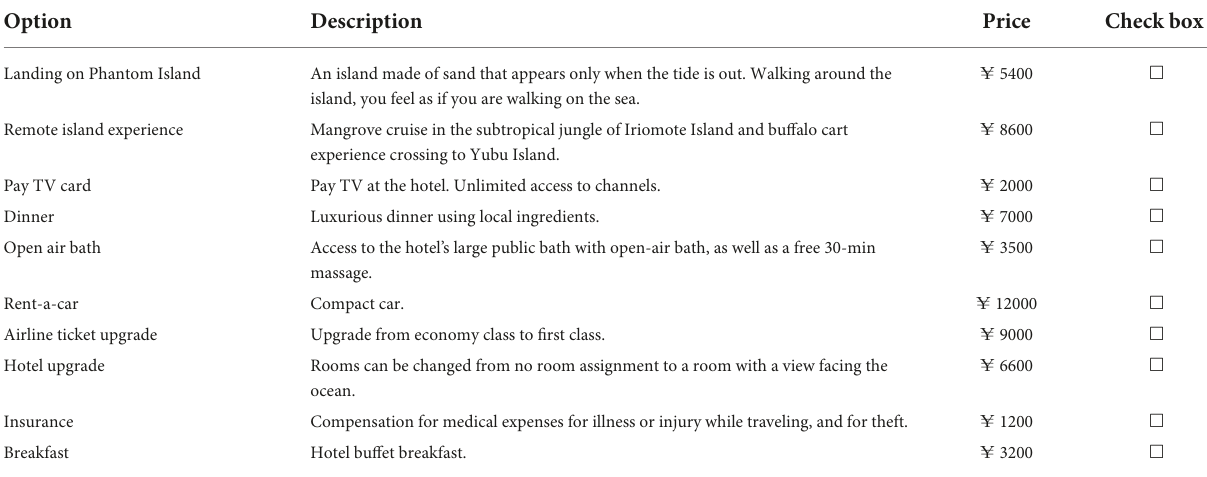
TABLE A Screen for choosing the travel package options in +OF. Please check the option if you do need it.